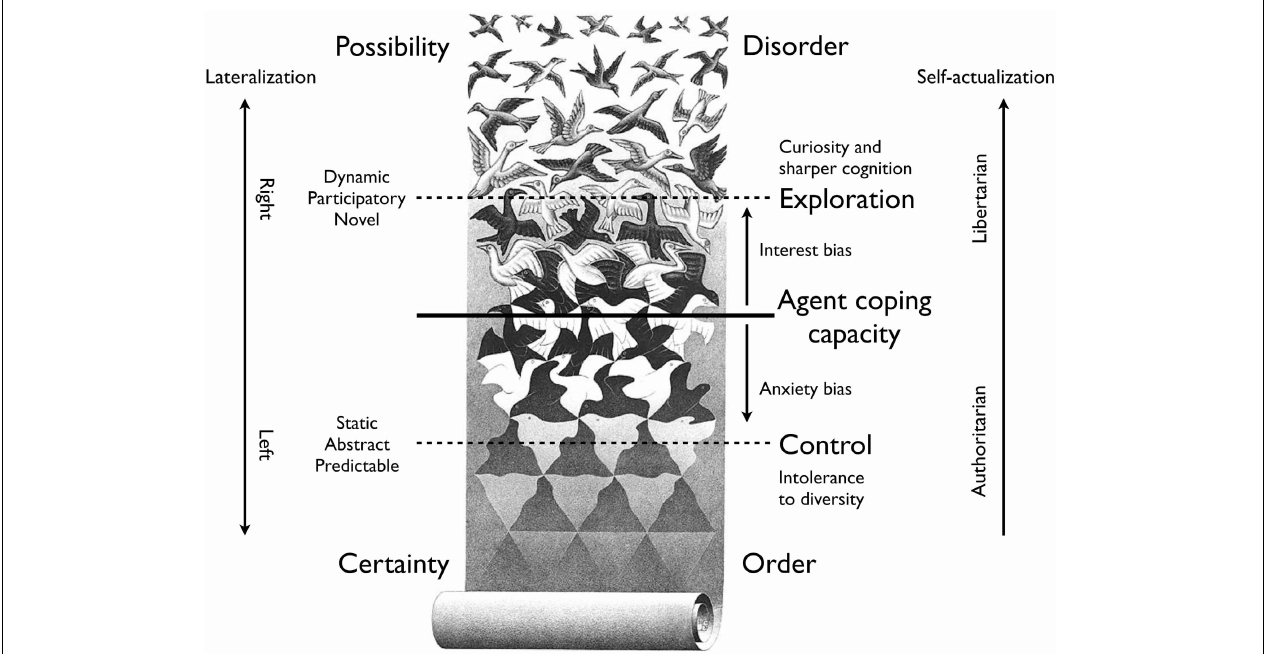
FIGURE 2 | Dealing with complexity. The anxiety-free response to increased complexity leads to curious exploration and sharper cognition, while the anxiety-laden response activates intolerance of diversity. This graphical depiction can be interpreted as agent development at some